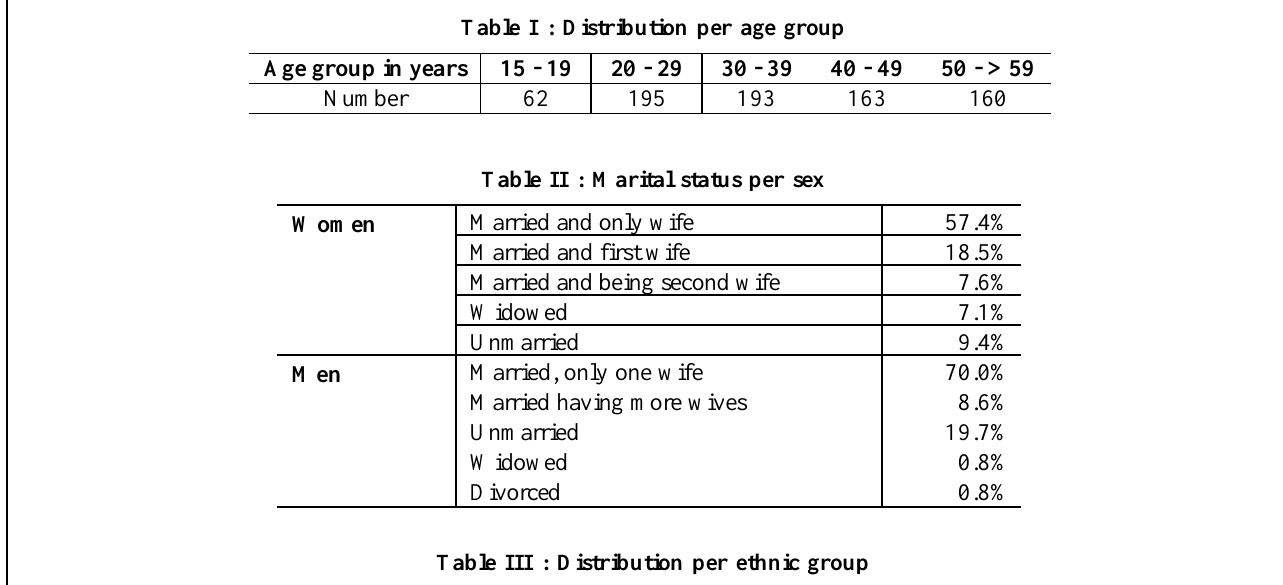
Table I : Distribution per age group